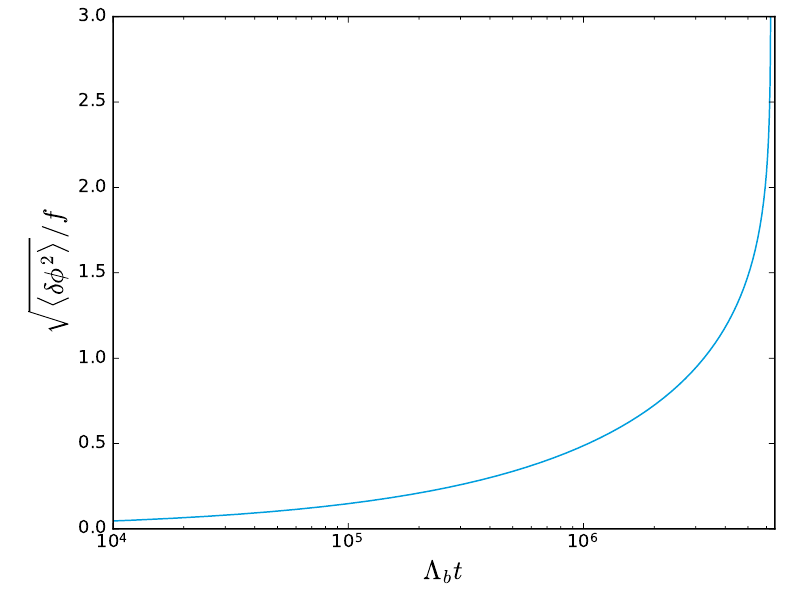
p h (cid:14)(cid:30) 2 i =f . The parameters are same as (cid:12)gure 11.